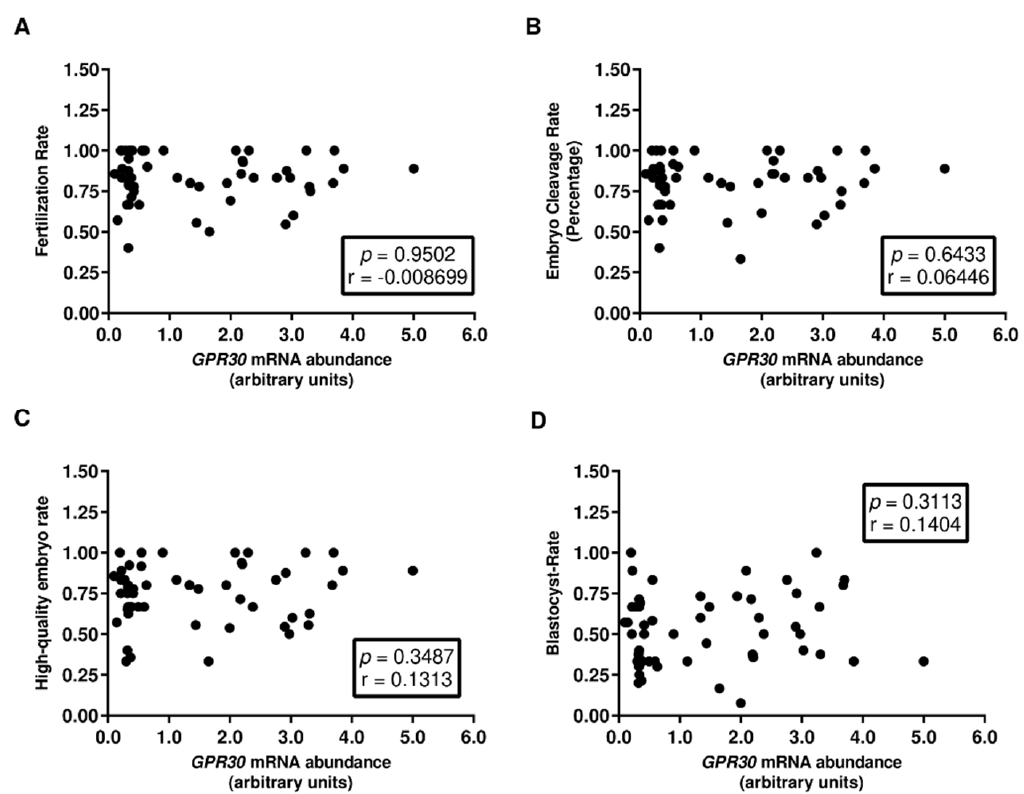
Figure 3. Association between GPR30 mRNA abundance in spermatozoa and embryo quality parameters. Association between GPR30 mRNA abundance in human spermatozoa and ( A ) fertilization rate ( n = 54), ( B ) embryo cleavage rate ( n = 54), ( C ) high-quality embryo rate ( n = 53), and ( D ) blastocyst rate ( n = 54) was evaluated by computing the Pearson correlation coefficients (r), assuming a Gaussian distribution (confidence interval of 95%). No correlations between the studied parameters were found to be statistically significant.